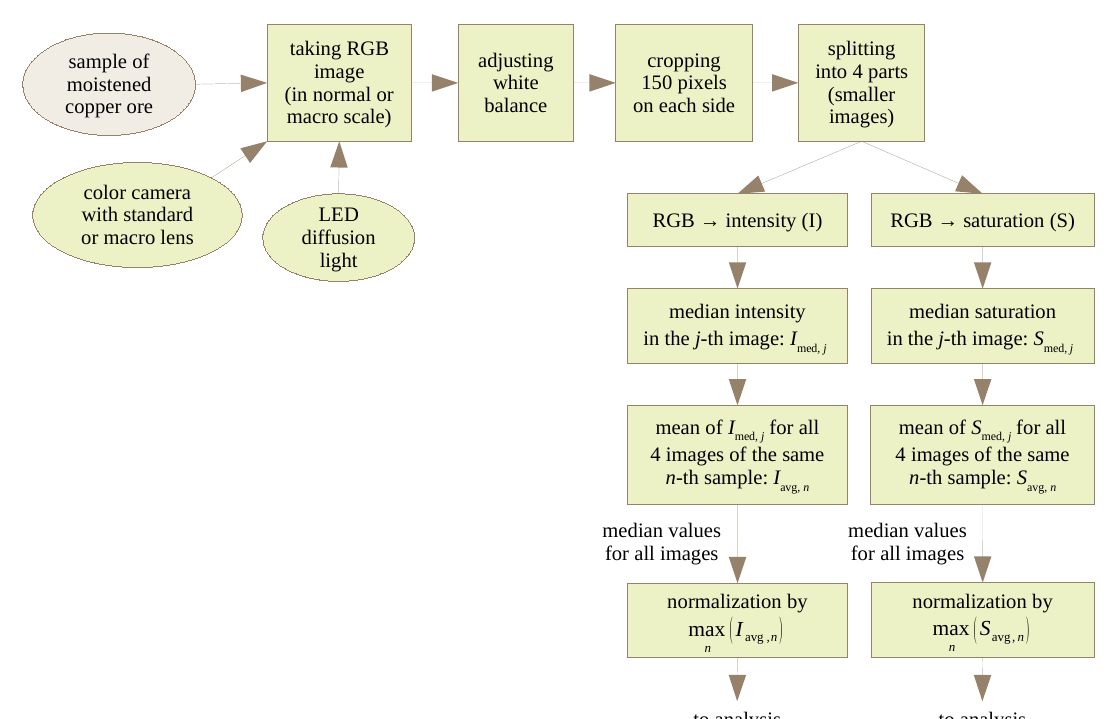
Figure 8. Stages of acquisition and processing of vision images.